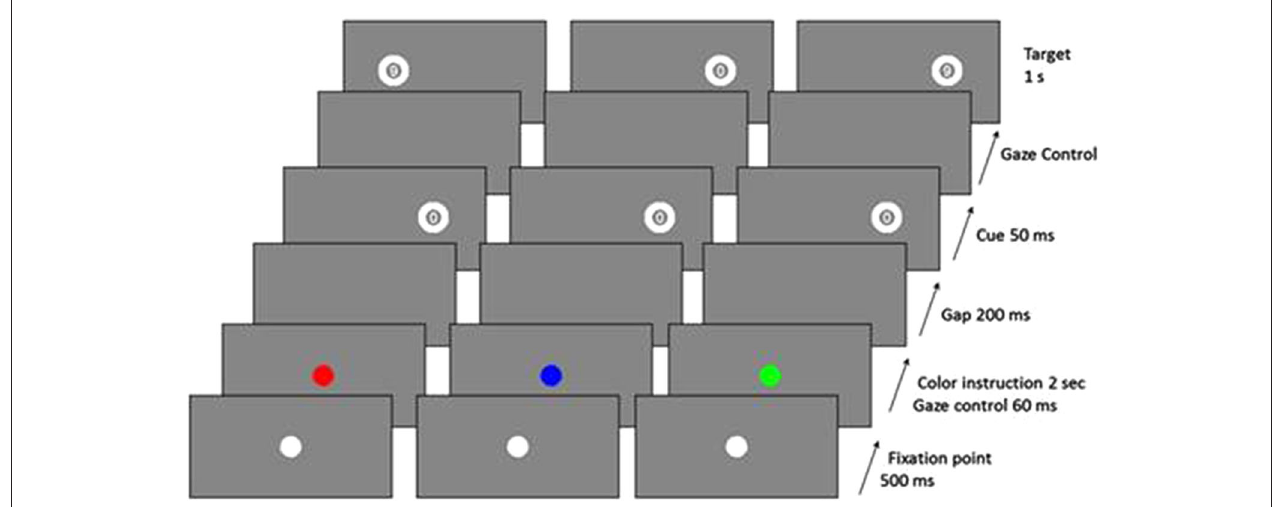
FIGURE 2 | Examples of trial sequences for the three trial types (red = AS, blue = NS, green = PS) (from Malsert et al., 2013) .